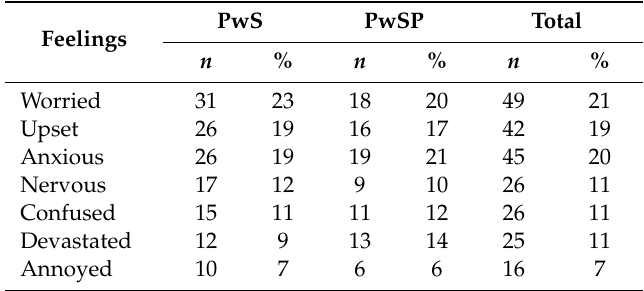
Table 3. Distribution of responses to pre-determined